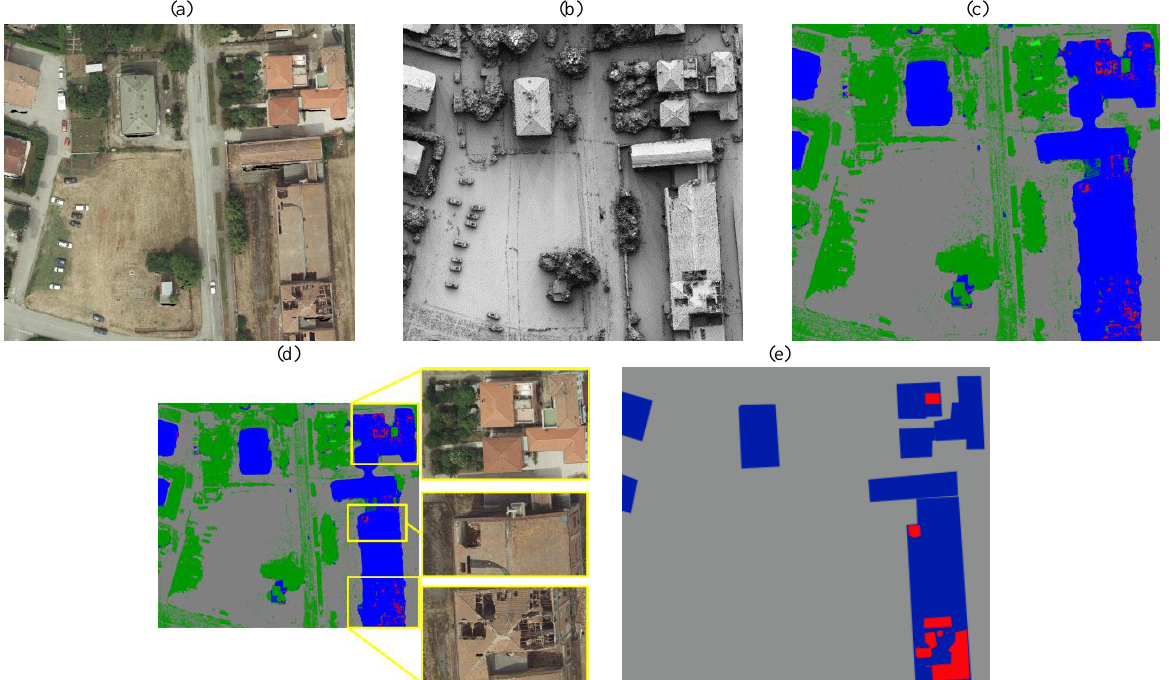
Figure 3: True orthophoto (a) generated from the extracted DSM (b) of Area 2. Results of the urban classification (c) with four classes: low vegetation (light green), high vegetation (dark green), ground (gray), building (blue). Automatically detected damaged buildings and the created classification map (d) - with close-up views on the original imagery: damaged (red), intact (blue). Manual identification of damaged / intact buildings